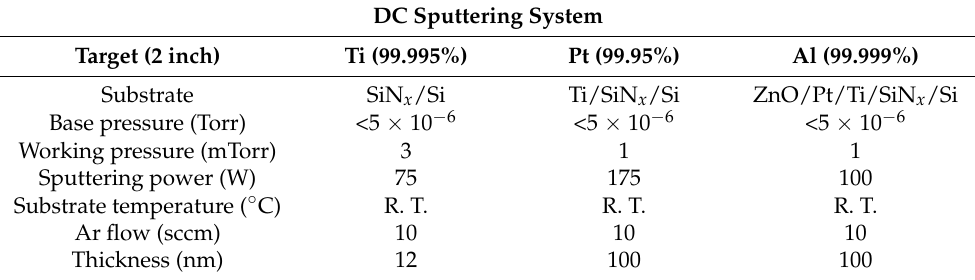
Figure 1. The fabrication processes of an FBAR device. Table 1. Deposition parameters of the bottom and top electrodes.